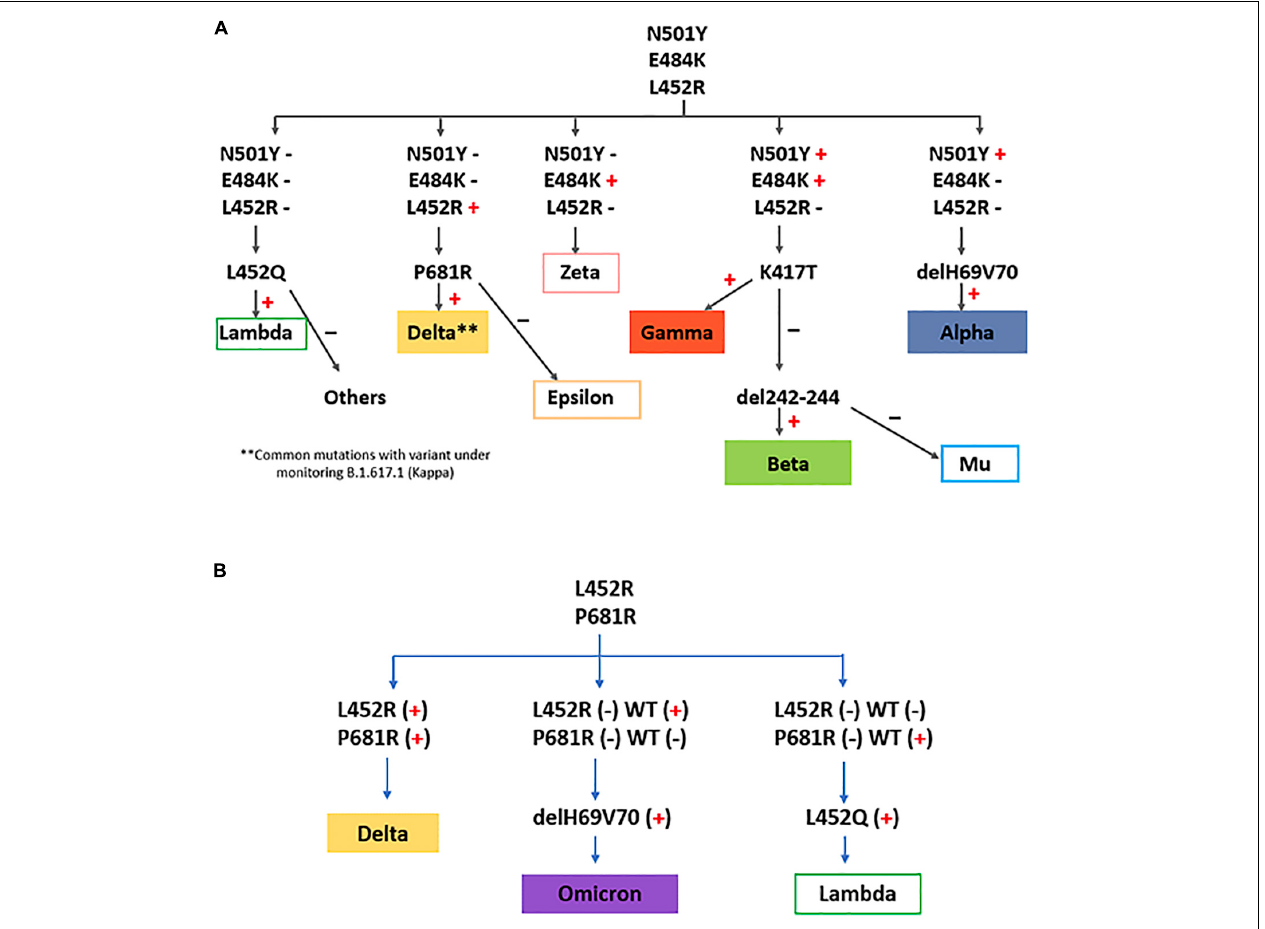
FIGURE 2 | VOC/VOI detection strategies implemented in this study, using consecutive real time RT-PCRs for relevant mutation screening adapted to the different epidemiological scenarios. (A) algorithm used until October 2021. (B) algorithm used since November